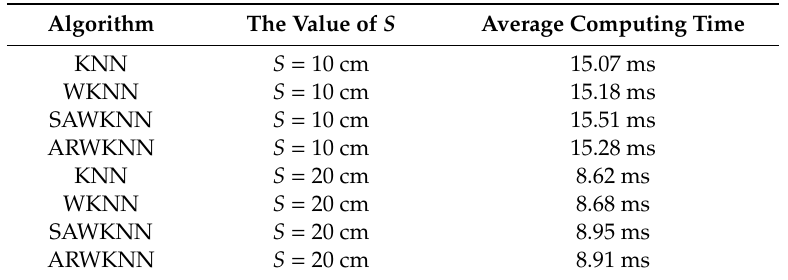
Table 6. Computational complexity